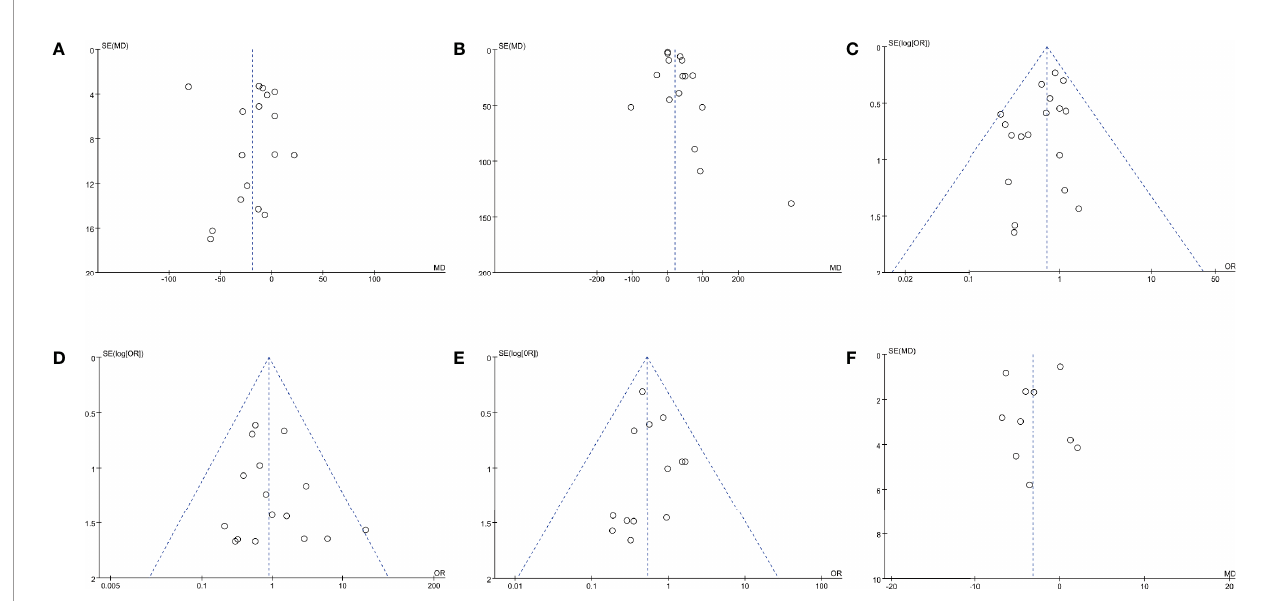
FIGURE 3 | Funnel plots of (A) operating time, (B) EBL, (C) complication rate, (D) transfusion rate, (E) positive surgical margins rate, and (F) long-term % decrease in